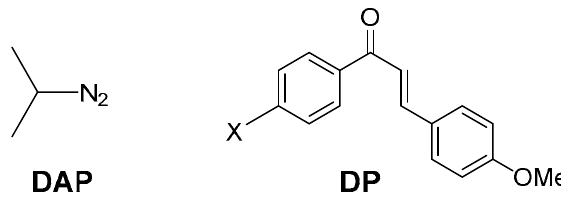
Figure 2. Diazpropane DAP and dipolarphile DP structures.